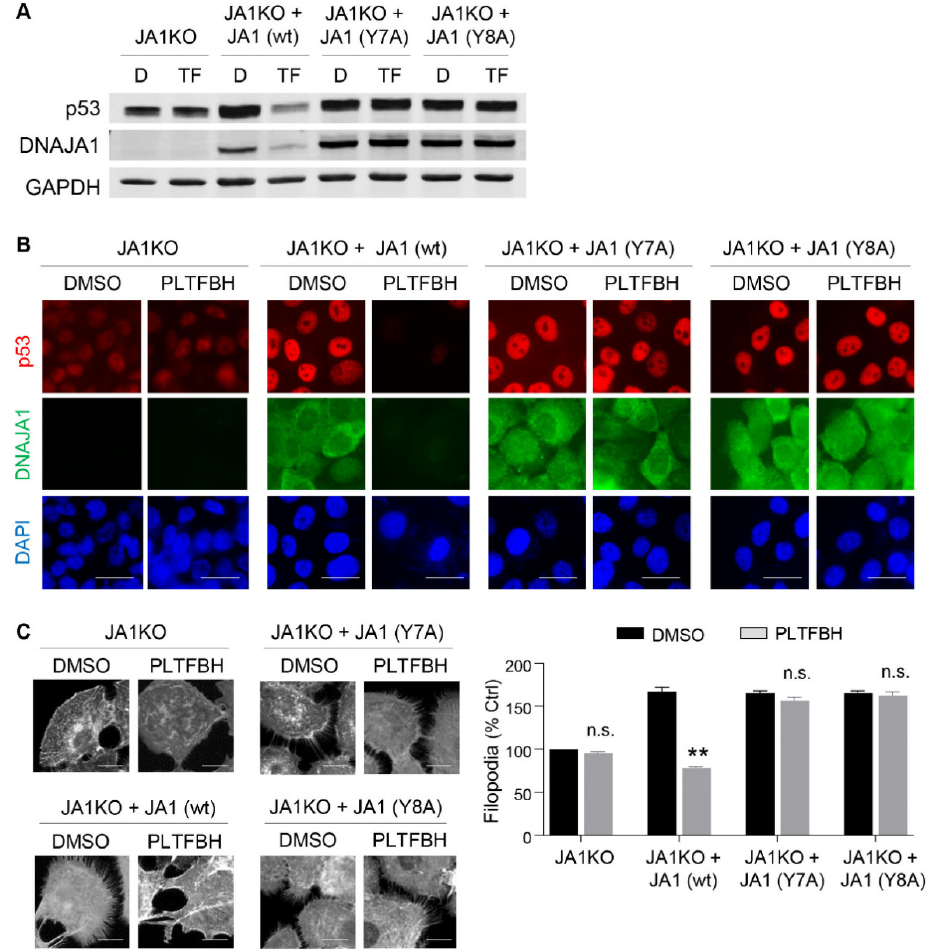
Figure 6. Mutations at Y7 and Y8 residues in DNAJA1 abrogate the ability of PLTFBH to deplete DNAJA1 and conformational mutp53. ( A ) Western blotting to detect exogenous DNAJA1 and GAPDH, as well as endogenous p53 (p53 C176F ), using DNAJA1 -knockout HN31 cells (JA1KO) ex- pressing exogenous wild-type (wt), Y7A mutant (Y7A), and Y8A mutant (Y8A) DNAJA1, treated with DMSO (D) or PLTFBH (TF) at ~1/2 IC 50 for 24 h. ( B ) Immunofluorescence for p53, DNAJA1, and DAPI using the same experimental set of HN31 sub-cell lines as in Figure 6A. Scale bar: 50 μm. ( C ) F-actin staining using the HN31 sub-cell lines treated with DMSO or PLTFBH at ~1/2 IC 50 for 24 h. Mean ± SEM from three independent experiments ( n = 3). ** p < 0.01 for two-tailed Student’s t- test. n.s.: not significant. Scale bar: 10 μm. Left : representative images. Right : summarized graph.